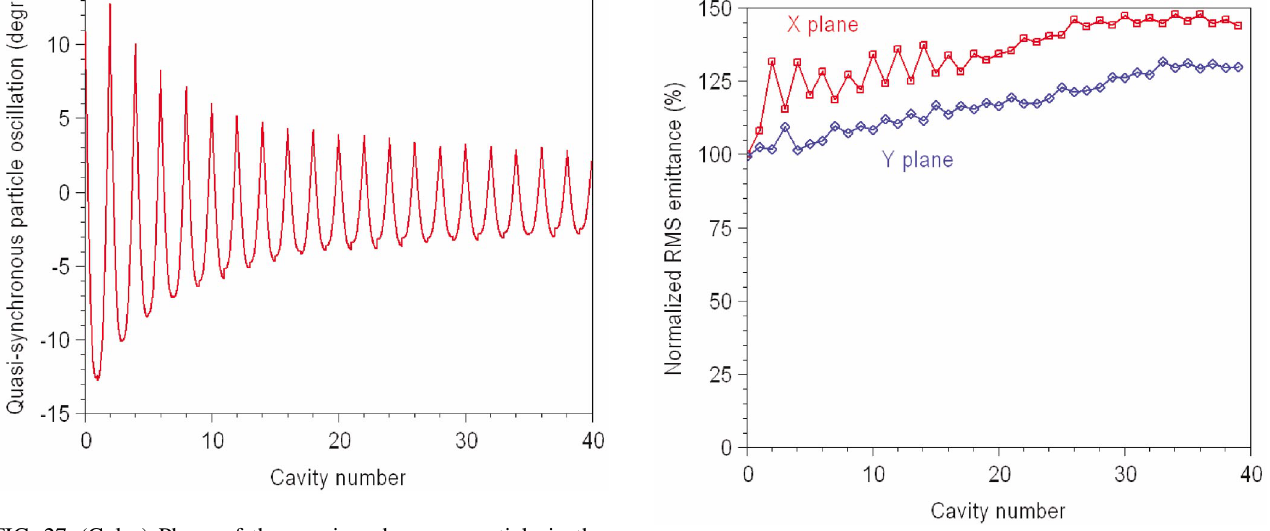
FIG. 27. (Color) Phase of the quasisynchronous particle in the linac with 2 cavities in each family.